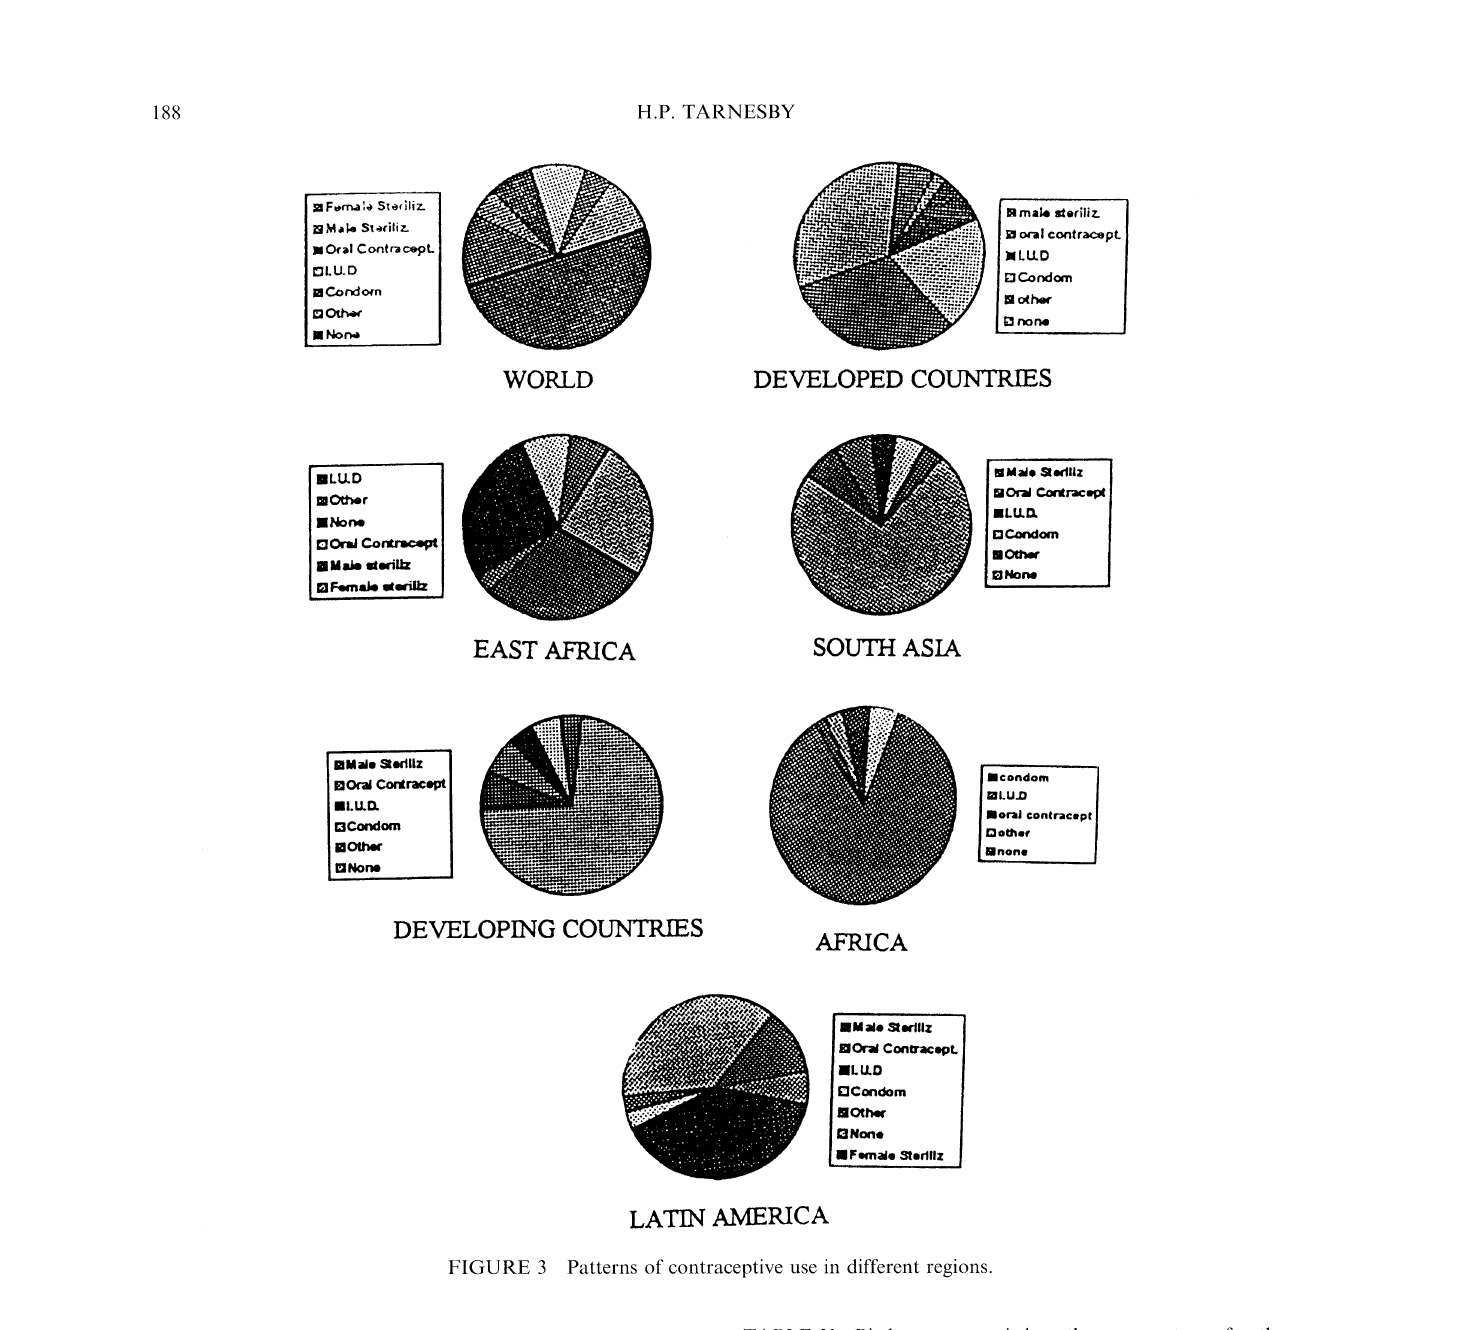
United States All races